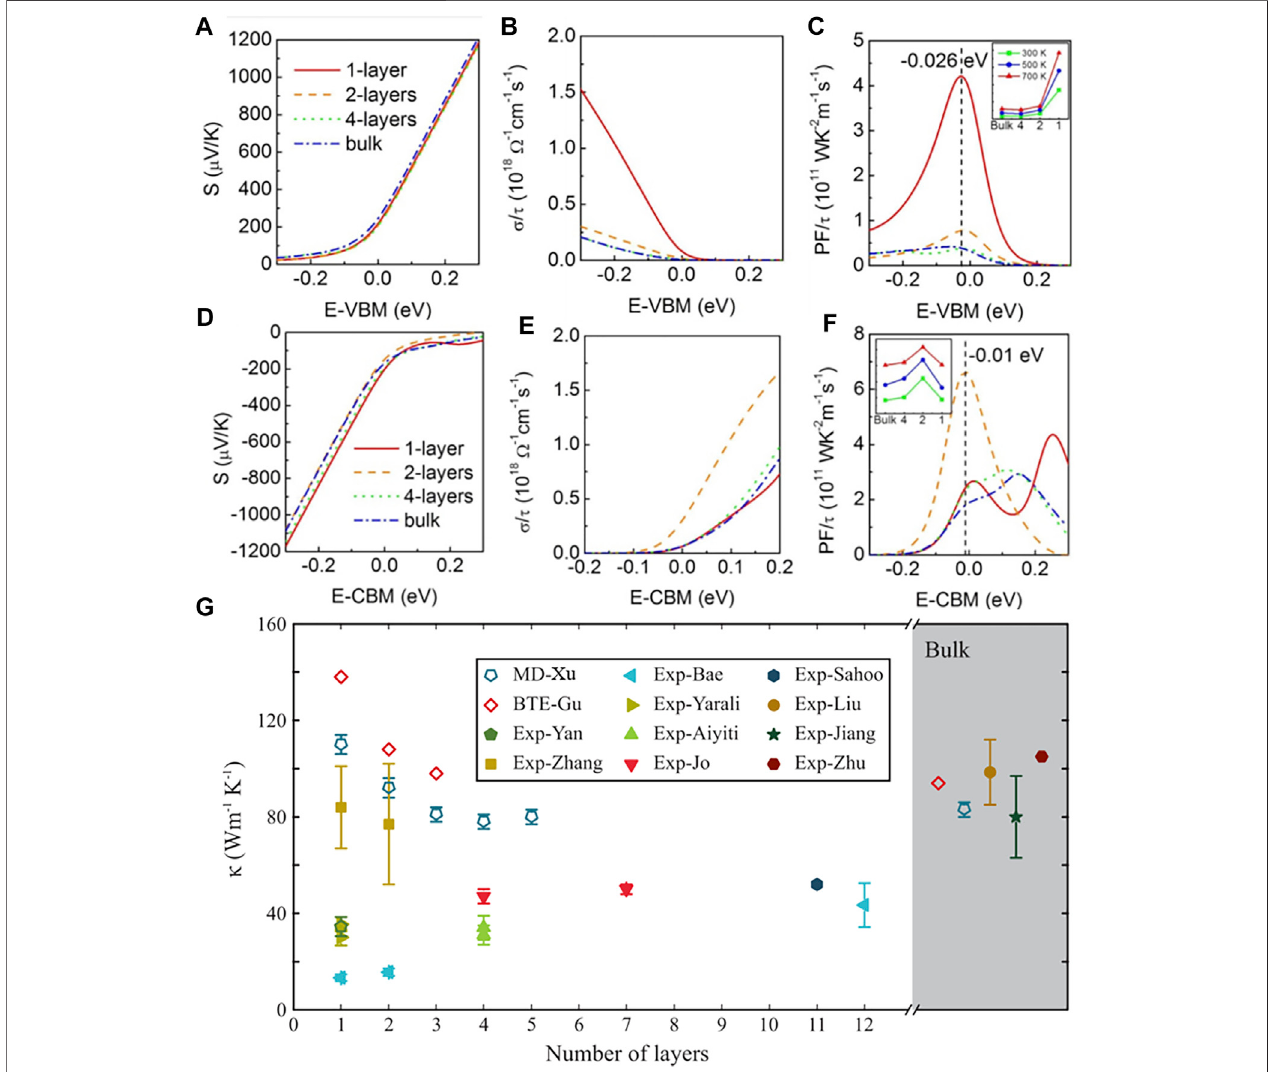
FIGURE 2 | In-plane Seebeck coef fi cient ( S ), electrical conductivity ( σ / τ ) and power factor ( PF / τ ) of MoS 2 at 300 K are plotted with variation of their thickness and chemical potential. (A – C) show the properties of p -type MoS 2 and (D – F) show the properties of n -type MoS 2 . The chemical potential 0.0 refers to the edges of valence andconductionbandfor p -and n -types,respectively.Theinsetsof (C,F) showthemaximumpowerfactorchangewiththetemperature.Reprintedwithpermissionfrom Ref.[34],Copyright2016,AmericanPhysicalSociety. (G) ThermalconductivityasafunctionofthenumberoflayersforMoS 2 at300 Kand zeropressure.Sources ofreferencedata:Gu[45];Aiyiti[47];Bae[48];Liu[49];Zhu[50];Jiang[51];Sahoo[52];Jo[53];Yan[54];Zhang[55];Yarali[56].ReprintedwithpermissionfromRef.[46], Copyright 2019, American Physical Society.